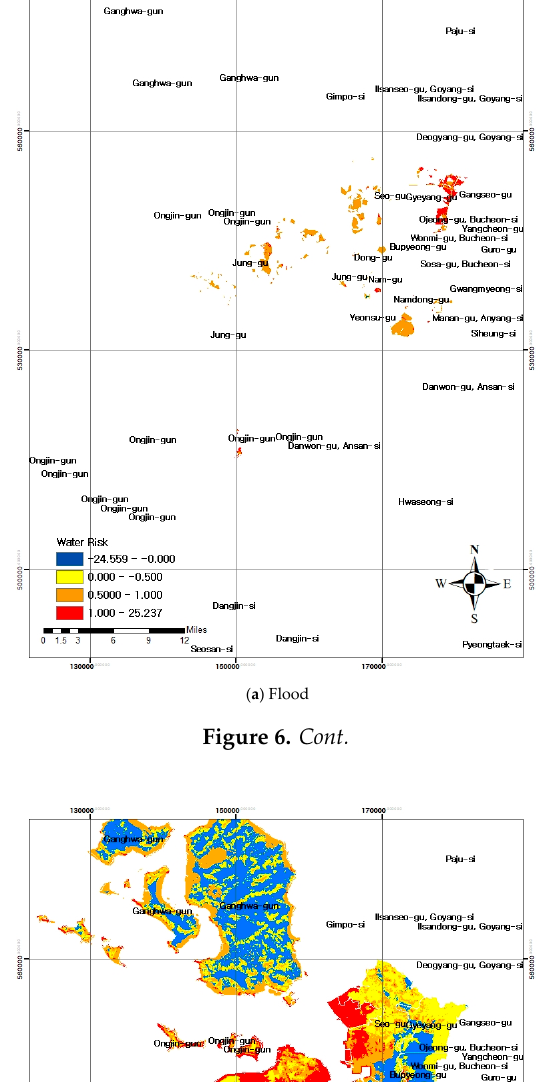
ISPRS Int. J. Geo-Inf. 2019 , 8 , x FOR PEER REVIEW